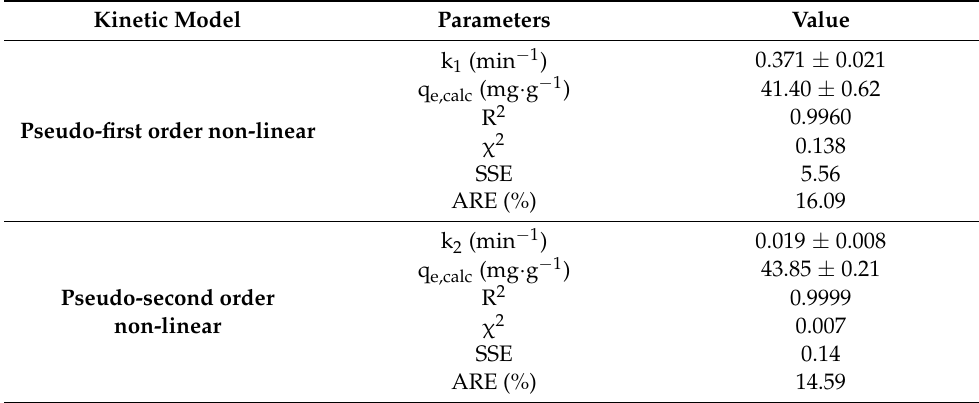
Table 5. Kinetic model constants and the corresponding error